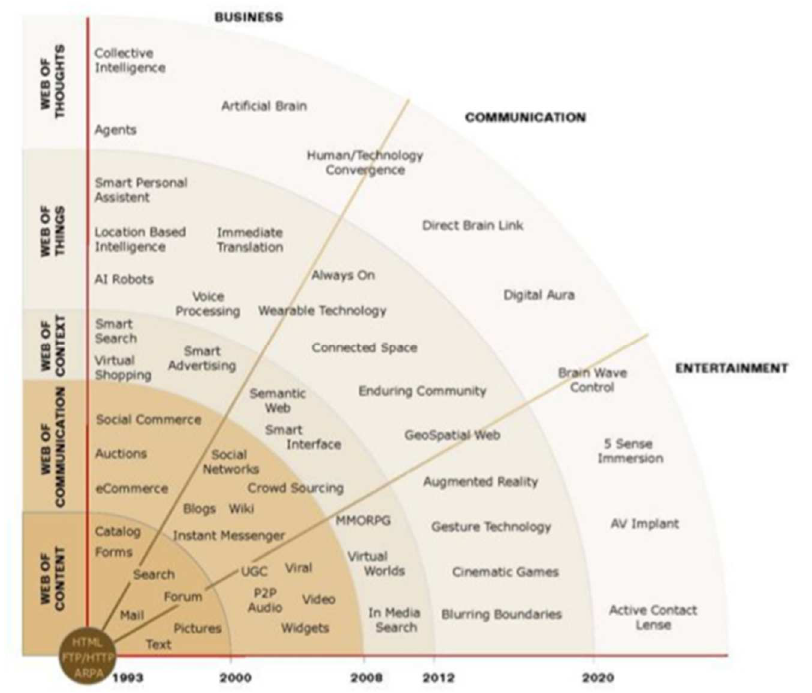
Figure 1: From the Web of Content to the Web of Thought